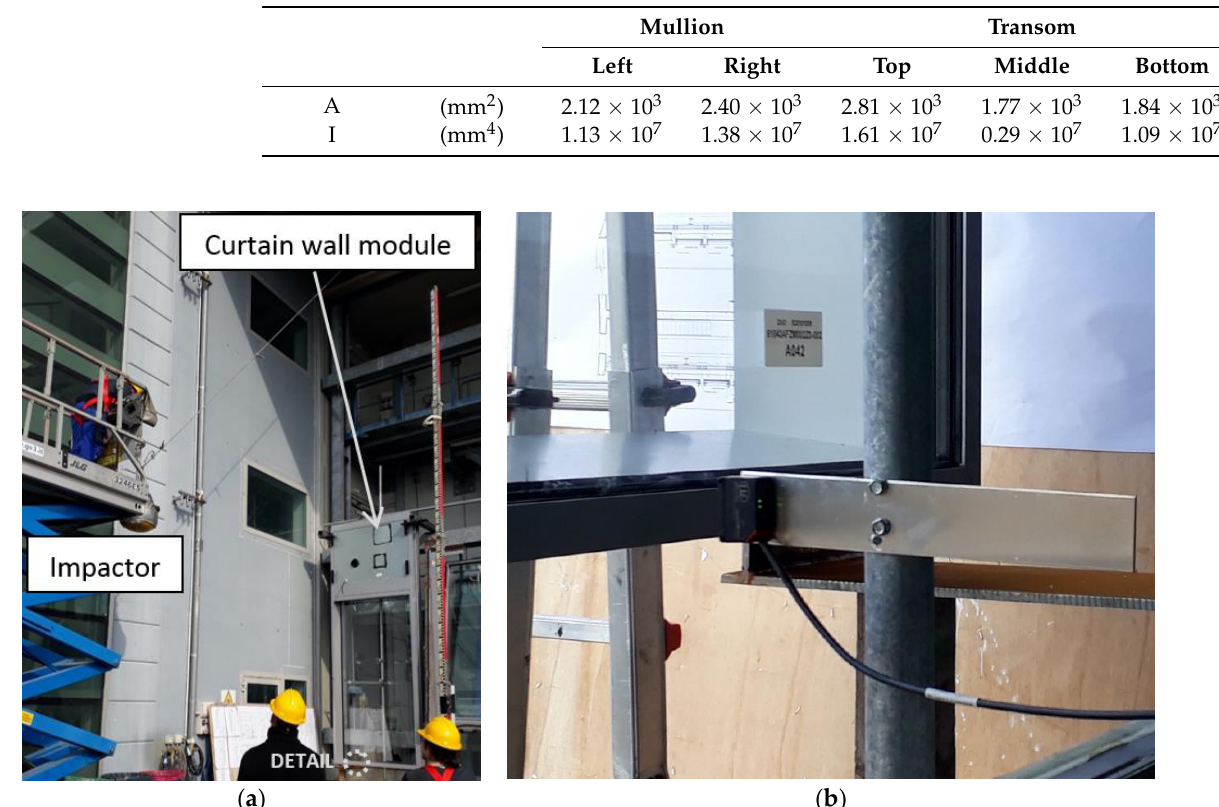
Figure 8. Impact experimental test with spheroconical bag: ( a ) tested curtain wall panel and ( b ) detail view of one of the laser sensors in use (bottom transom).